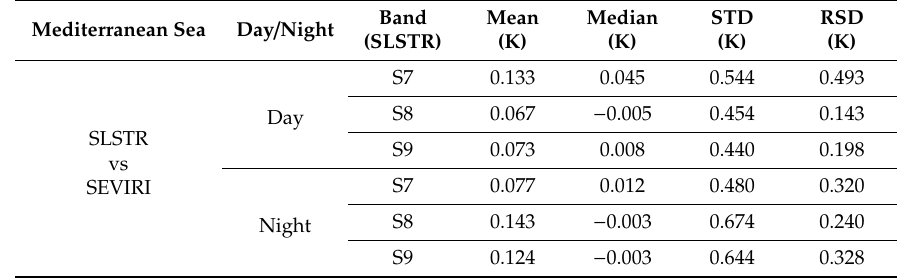
Figure 14. As shown in Figure 11, but for nighttime. Table 5. Statistics of SLSTR BTs minus SEVIRI equivalent BTs in the Mediterranean Sea area.